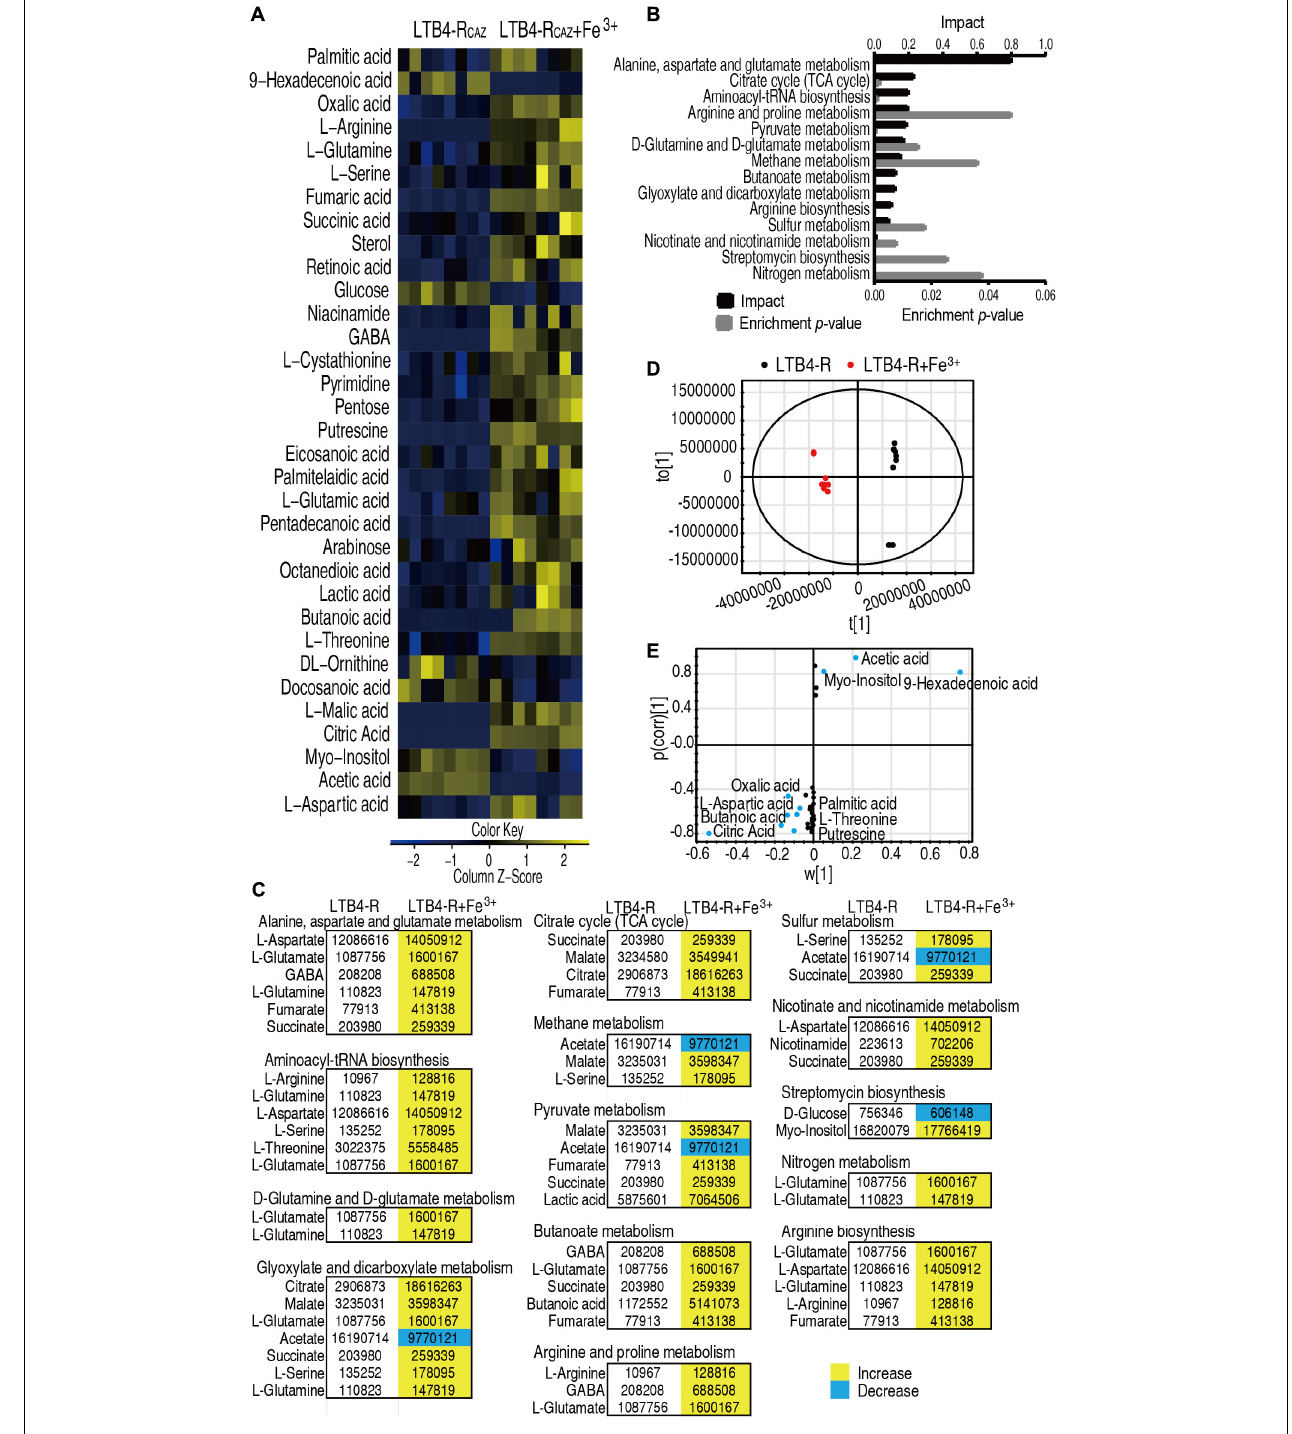
FIGURE 4 | Differential metabolomics of LTB4-R CAZ in response to Fe 3 + . (A) Heat map showing differential abundance of metabolites. Yellow and blue indicate increase and decrease of metabolites relative to the median metabolite level of the control, respectively (see color scale). (B) Pathway enrichment of varied metabolites in LTB4-R CAZ . (C) Integrative analysis of metabolites in significantly enriched pathways. Yellow and blue indicate increased and decreased metabolites, respectively. (D) PCA of LTB4-S and LTB4-R CAZ . Each dot represents the technical replicate analysis of samples in the plot. (E) S-plot generated from OPLS-DA. Predictive component p [1] and correlation p (corr) [1] differentiate LTB4-R CAZ from LTB4-S. Dot represents metabolites, and candidate biomarkers are highlighted in blue.